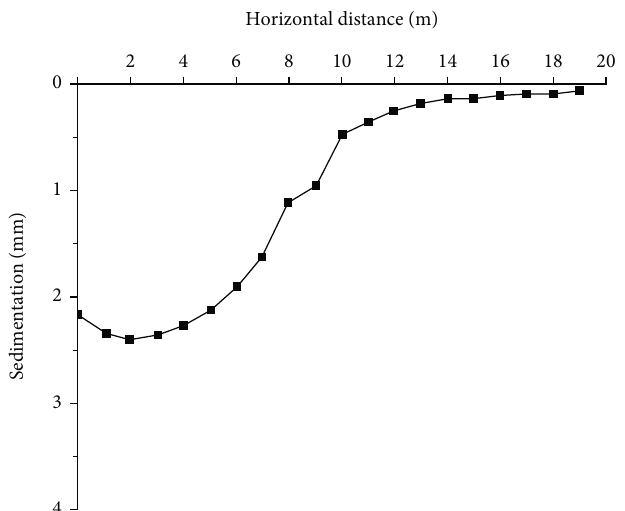
Figure 10: Simulation curve of horizontal displacement of pit roof after